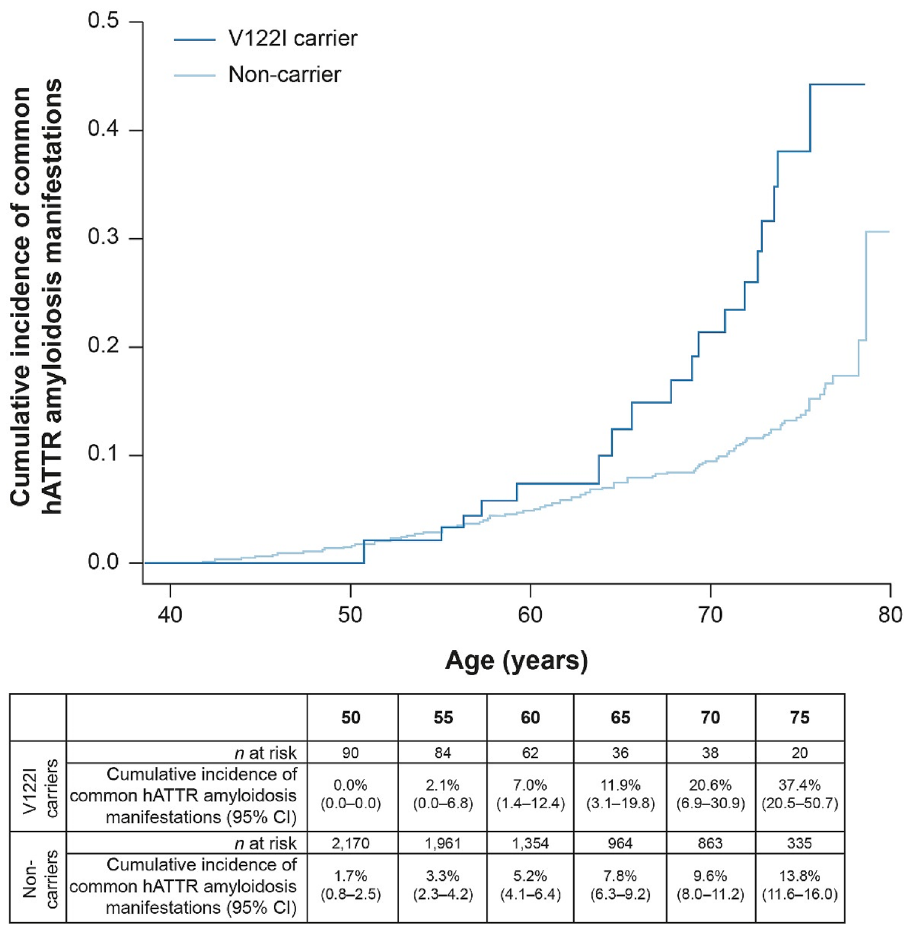
Figure 2. Cumulative incidence of common hATTR amyloidosis manifestations by V122I genotype in the UK Biobank (HR = 2.77, p = 2.62 × 10 –5 ). CI confidence interval, hATTR hereditary transthyretin-mediated, HR hazard ratio, V122I valine-to-isoleucine substitution at position